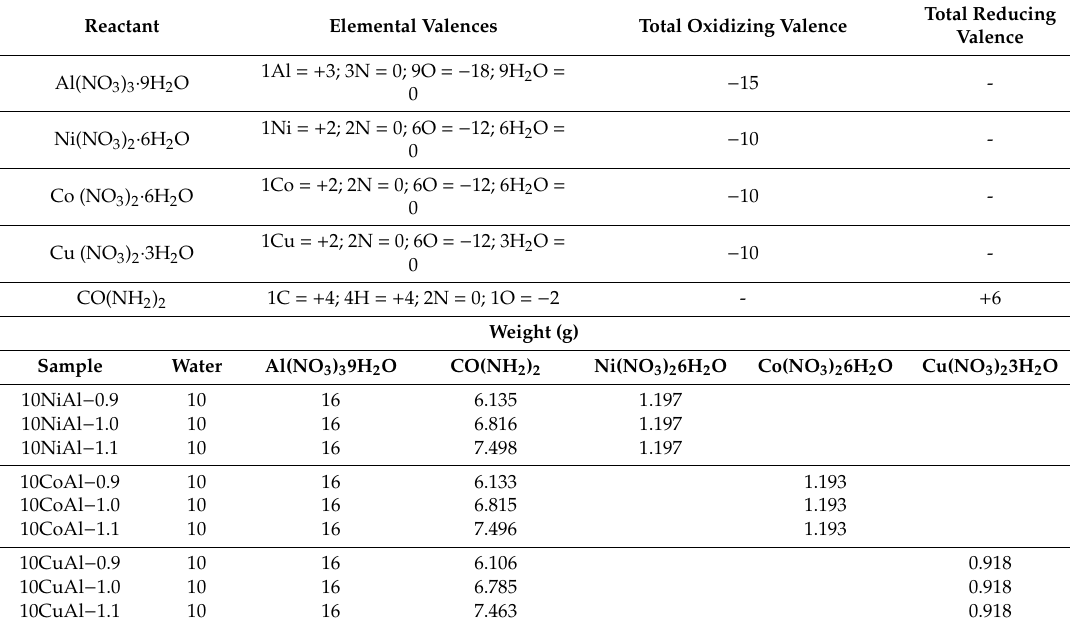
Table 1. Oxidizing and reducing valences and quantities of the di ff erent chemical reagents used to prepare the di ff erent catalysts.